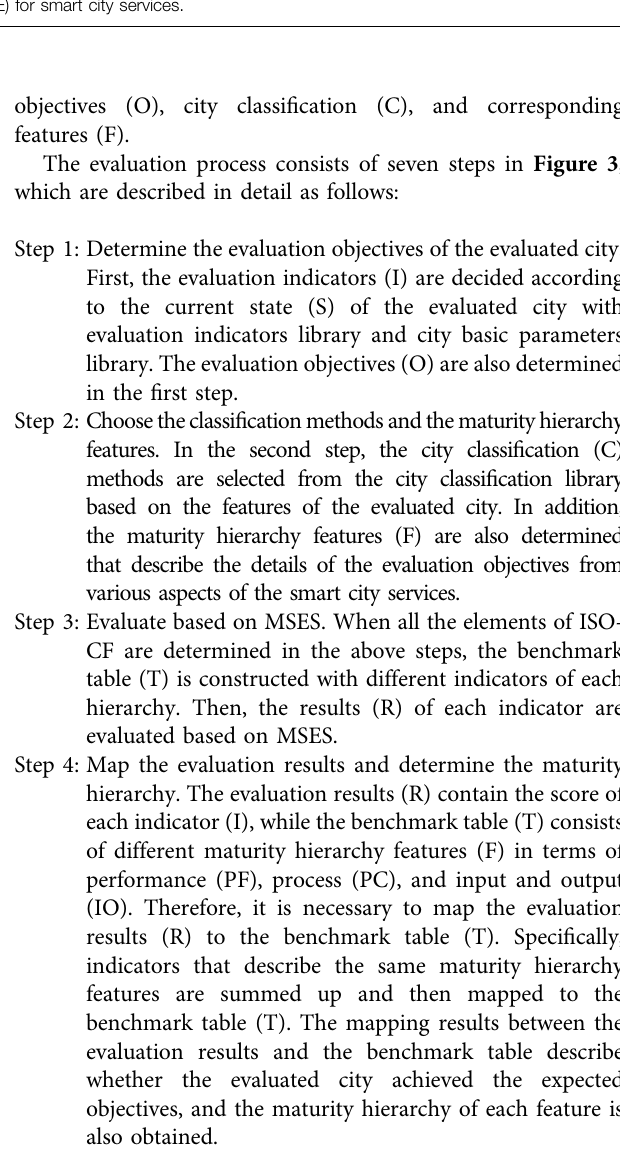
Frontiers in Environmental Science |